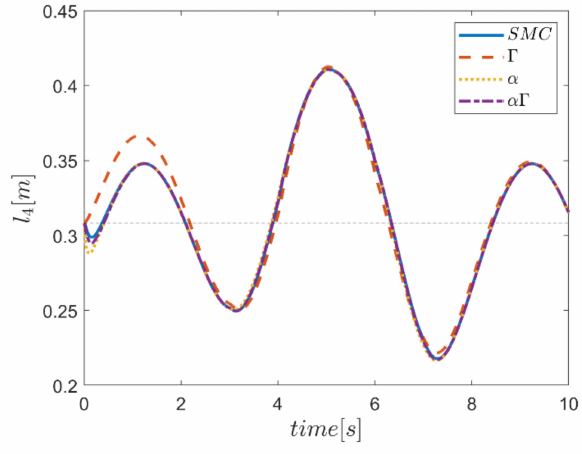
Figure 37. Comparison of the length of the fourth actuator.